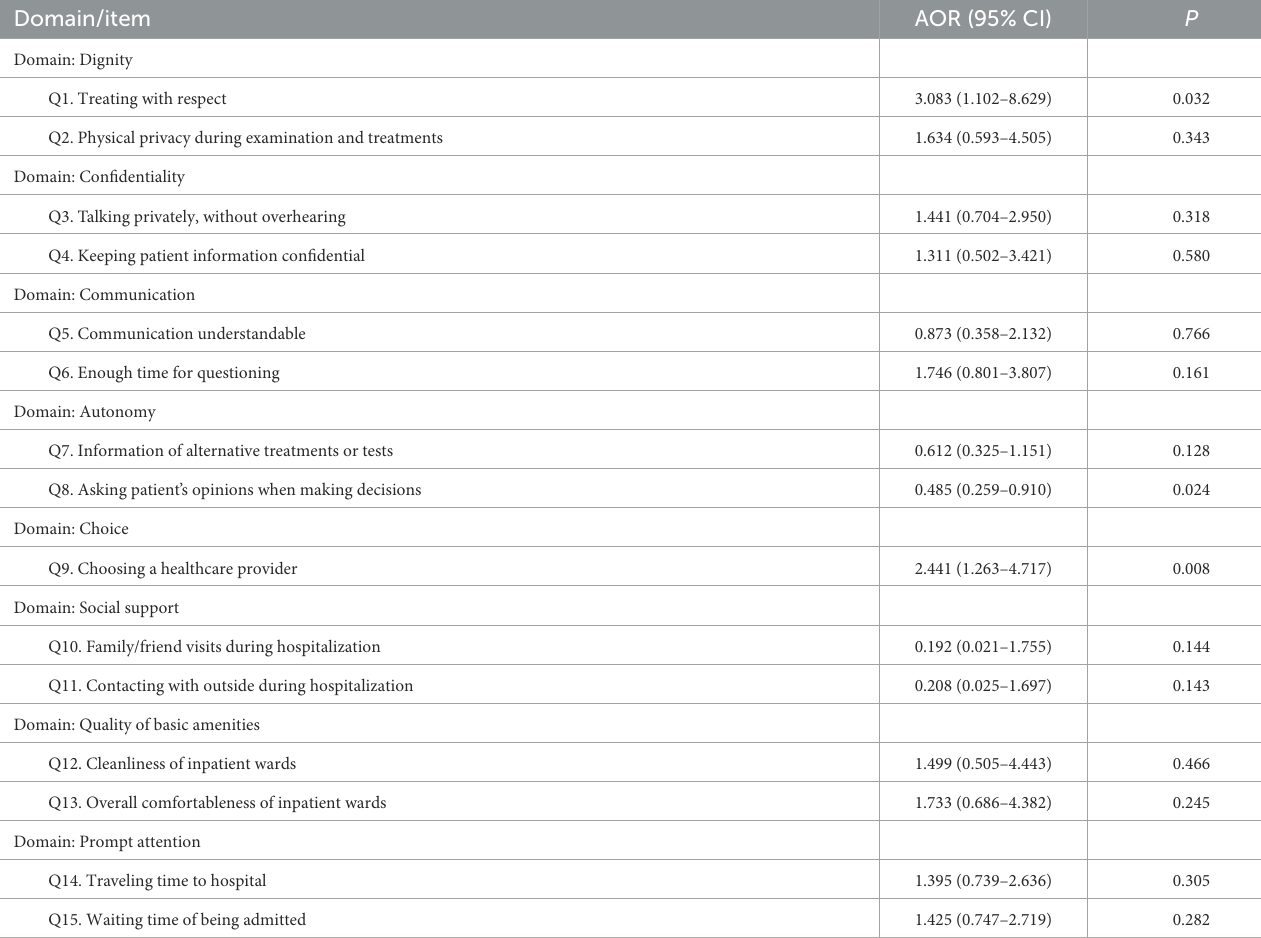
TABLE 3 Multivariate logistic regression analysis to control confounders in quality comparison between mental health and physical health inpatient services.